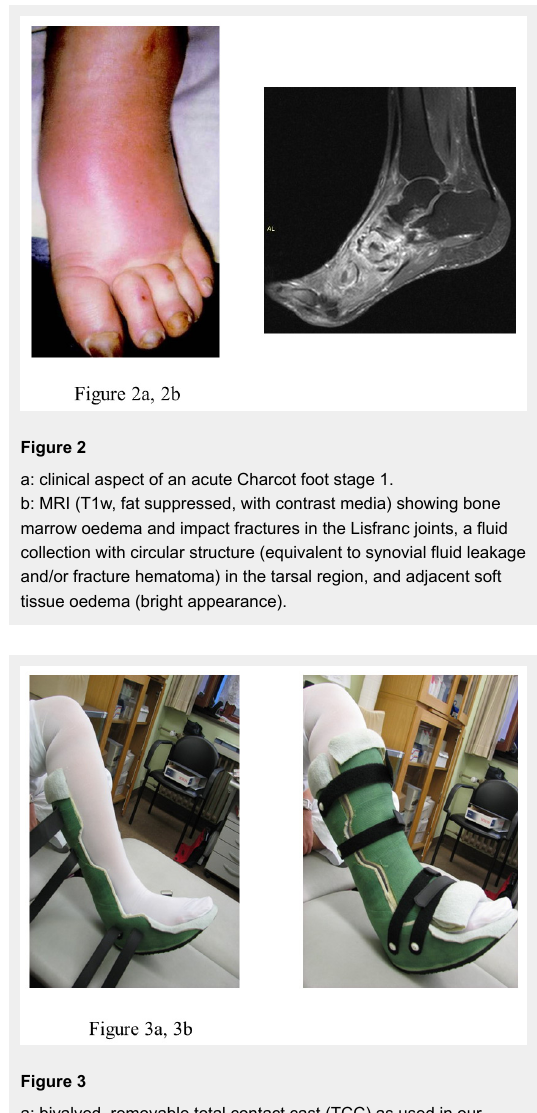
a: bivalved, removable total contact cast (TCC) as used in our institution, opened; leg is covered with compression stocking. b: TCC